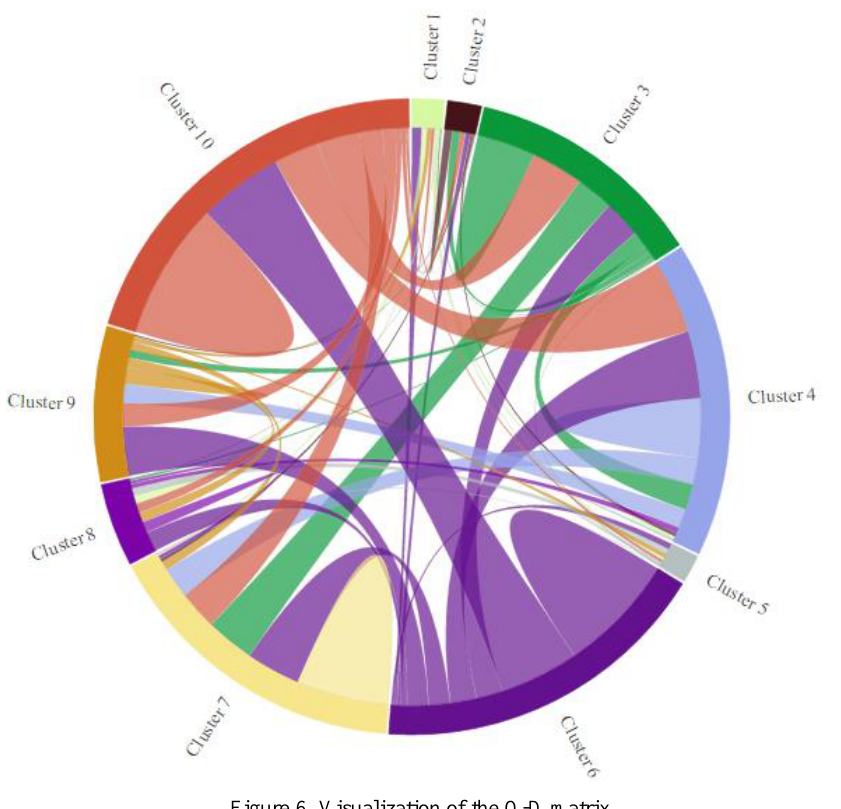
Figure 6. Visualization of the O-D matrix